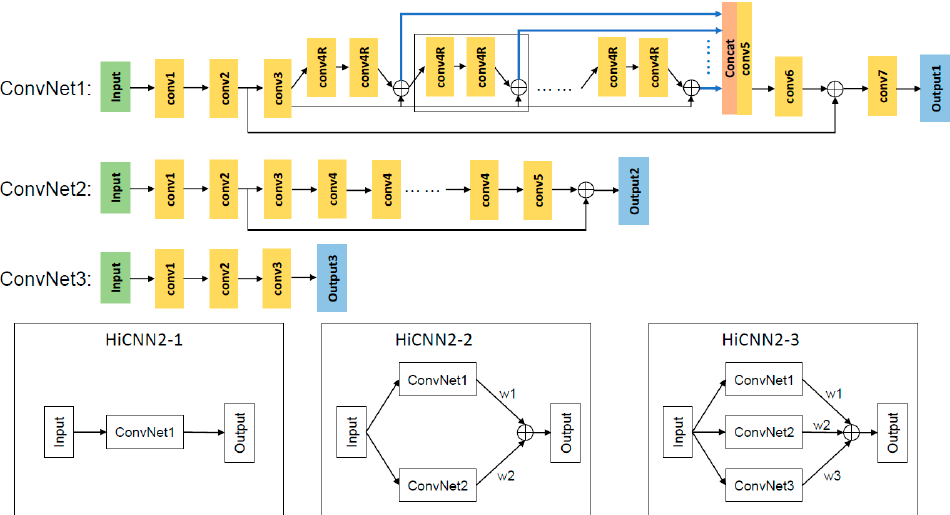
Figure 1. The detailed layouts of the three types of convolutional neural networks (ConvNet1, ConvNet2, and ConvNet3). ⊕ denotes element-wise addition. The dashed box in ConvNet1 highlights a local residual learning block. The blue lines in ConvNet1 denote hierarchical features. The “Concat” layer in ConvNet1 is used to concatenate all hierarchical features from each of the local residual learning blocks. HiCNN2-1 only uses ConvNet1; HiCNN2-2 is an ensemble of ConvNet1 and ConvNet2; and HiCNN2-3 is an ensemble of the three ConvNets.